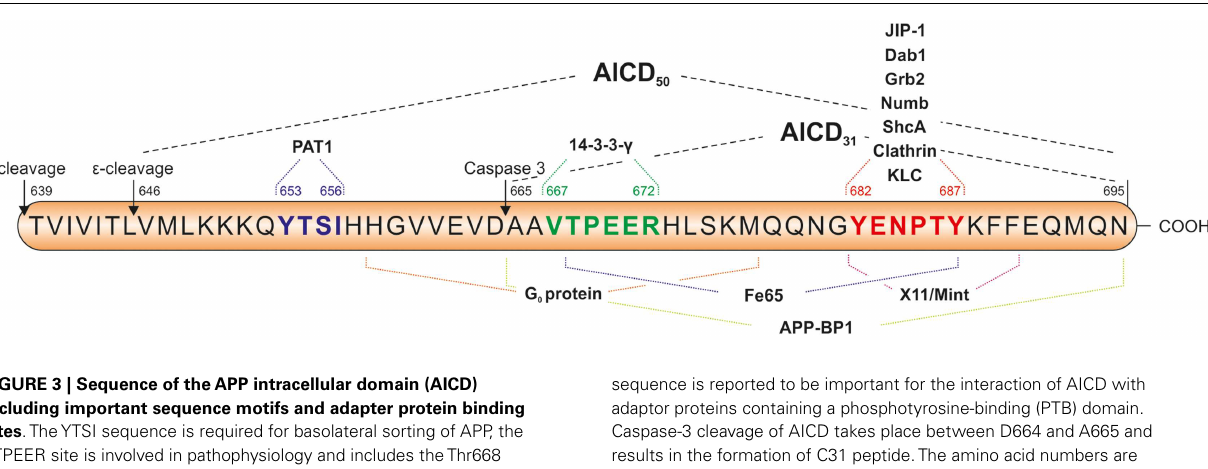
sequence is reported to be important for the interaction of AICD with adaptor proteins containing a phosphotyrosine-binding (PTB) domain. Caspase-3 cleavage of AICD takes place between D664 and A665 and results in the formation of C31 peptide.The amino acid numbers are referring to the APP695